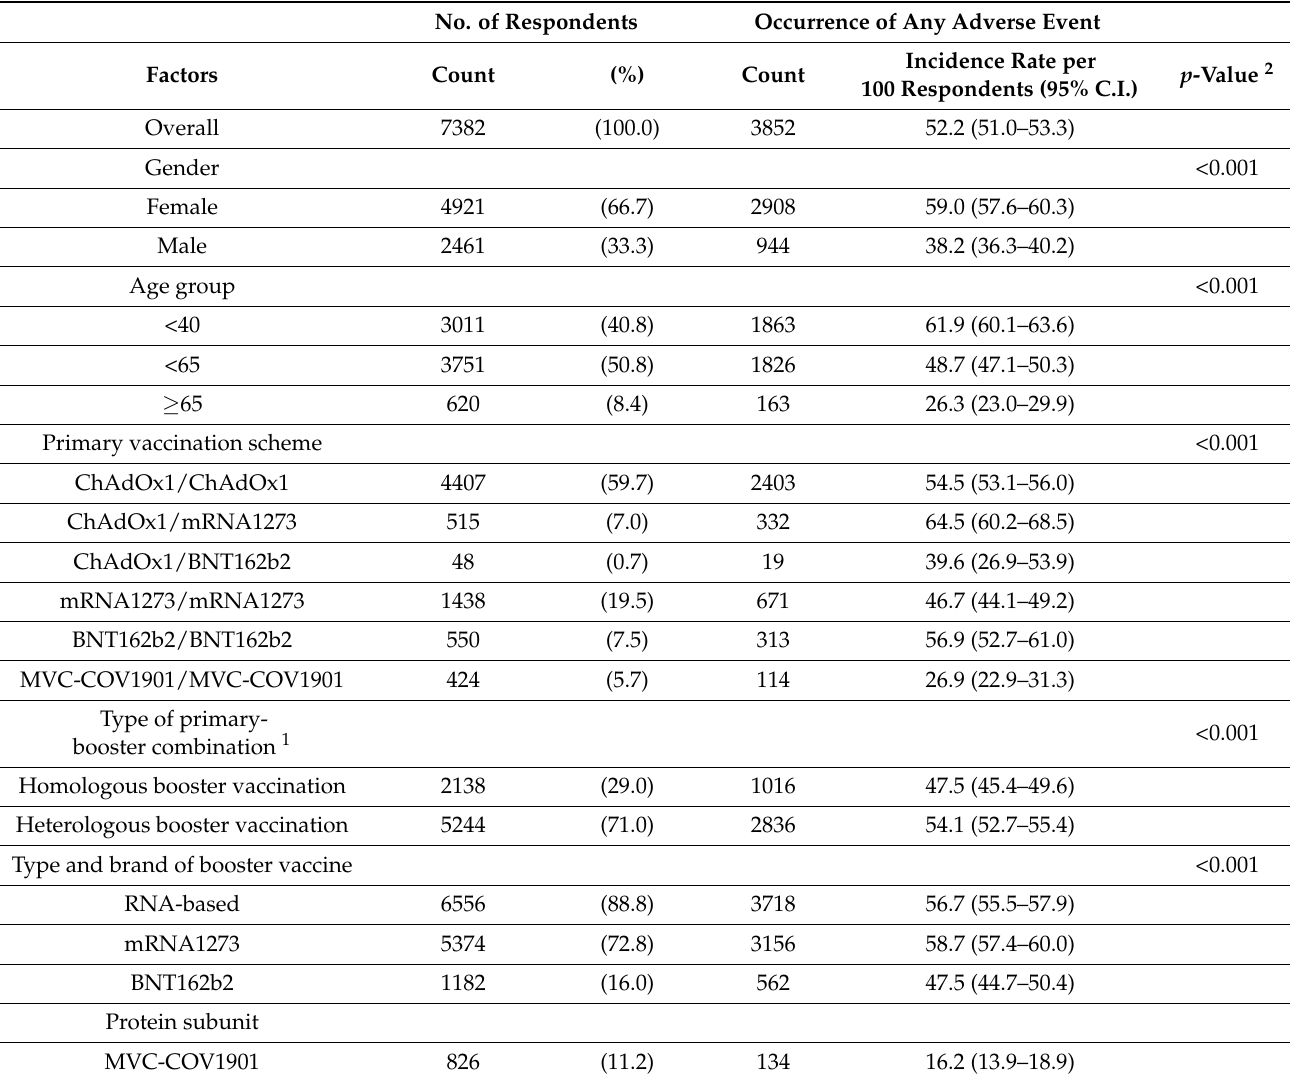
Table 2. Characteristics and adverse events (AE) reported to hospital-based Vaccine Adverse Event Reporting System (VAERS) for persons who respond a COVID-19 vaccine booster dose from 13 December 2021 to 13 March 2022, at the vaccination station of the Taipei Veterans General Hospital, Taipei, Taiwan (n = 7382, Taipei,